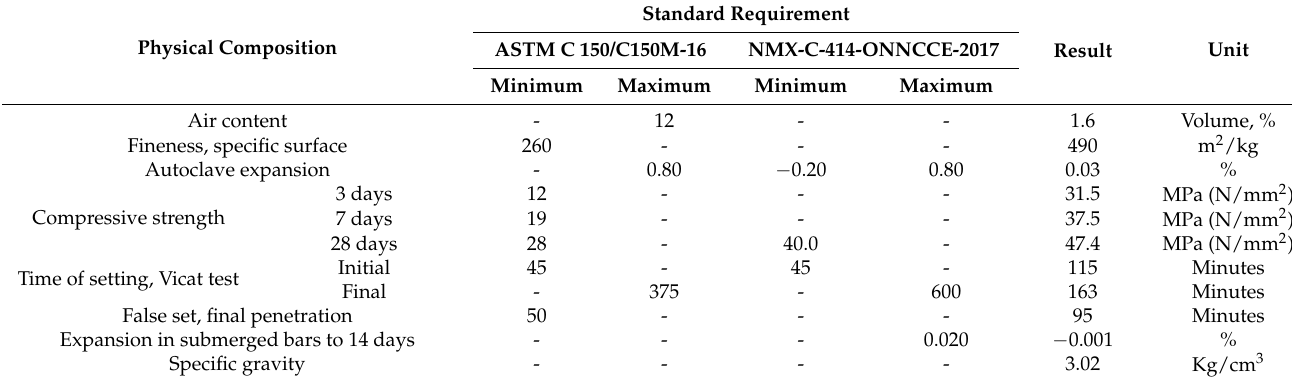
Table 2. Physical properties of cement.